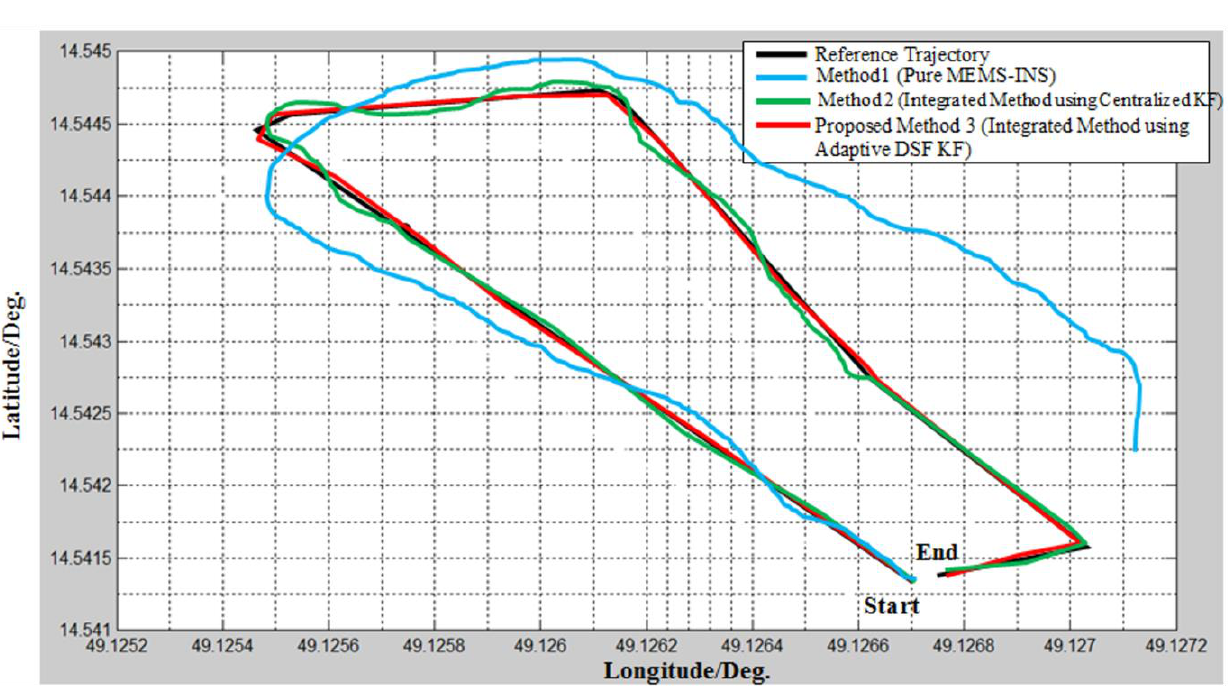
Figure 11. Estimated trajectories with the three integrated methods.